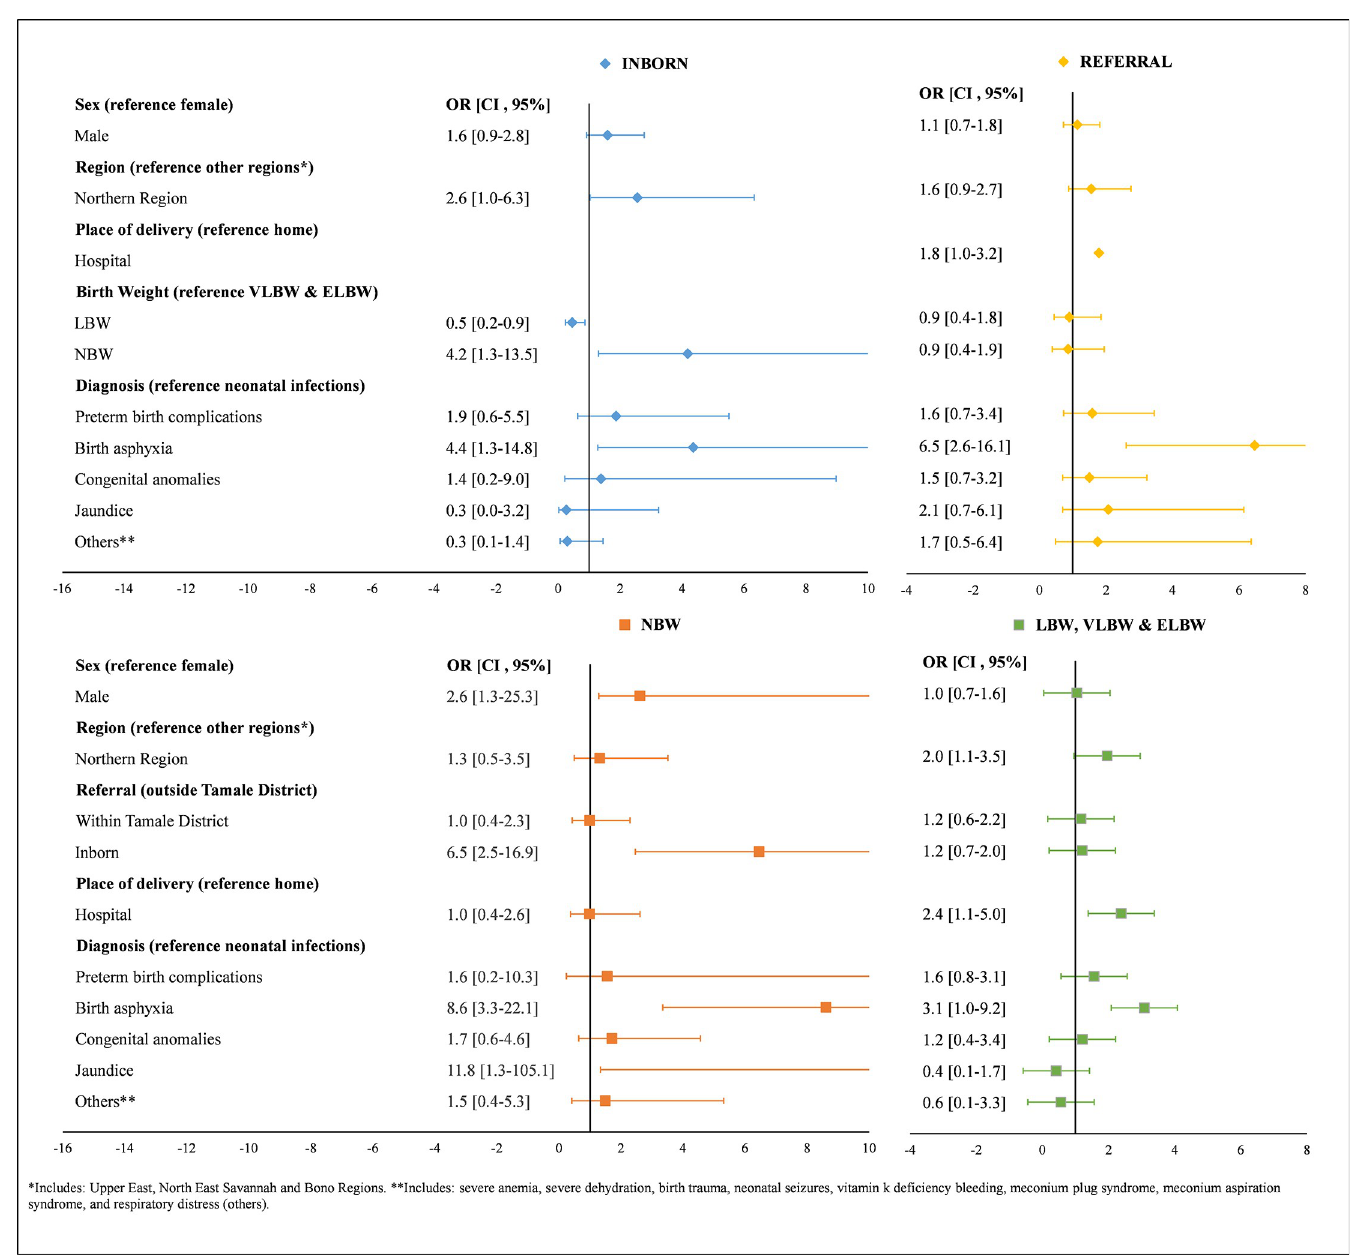
Fig 3. Predictors of early timing of neonatal death stratified by referral (inborn, referral) and birth weight (NBW, LBW, VLBW & ELBW).